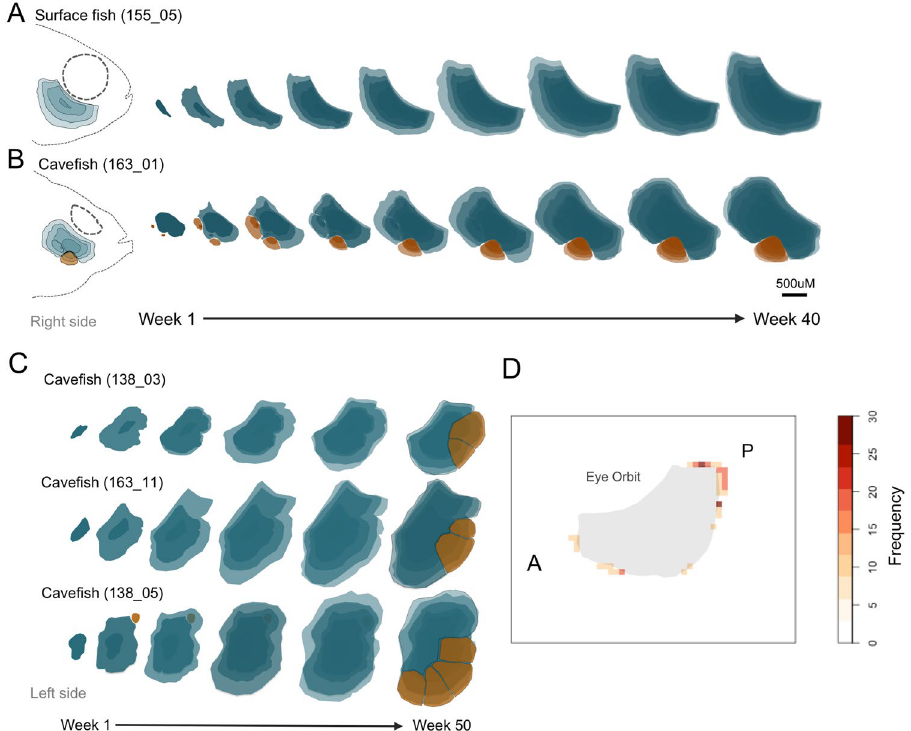
Figure 1. Two distinct developmental mechanisms underlie cranial bone fragmentation in Astyanax cavefish. An individual surface fish (155_05) demonstrates normal right-sided SO3 bone growth from a single ossification center (1°OC; blue animation) over 40 weeks ( A ). Cavefish display two novel ossification mechanisms that underlie fragmentation of cranial bones ( B , C ). Cavefish specimen 163_01 exhibited a 1°OC (blue) and multiple 2°OCs (orange) on the right side of the face, some of which were resorbed into the 1°OC, while the more anterior 2°OC persisted as a distinct fragment ( B ; mechanism 1). SO3 ossification on the left side of the face for cavefish individuals 138_03 and 163_11 stemmed from a 1°OC, but displayed irregular shape in growth, and eventually underwent post-ossification bone remodeling by 50 wpf, forming fragments ( C ). Cavefish 138_05 displayed both mechanisms, with an early 2°OC in the posterior that was resorbed by 20 wpf and evidence of post-ossification bone remodeling by 50 wpf that resulted in 5 fragments ( C ; mechanism 2). A spatial analysis visualised as a heat map revealed an increase in frequency of bone remodeling initiation sites across cavefish individuals (n = 30) at the posterior margin of the SO3 bone ( D ). The scale bar represents 500 μ